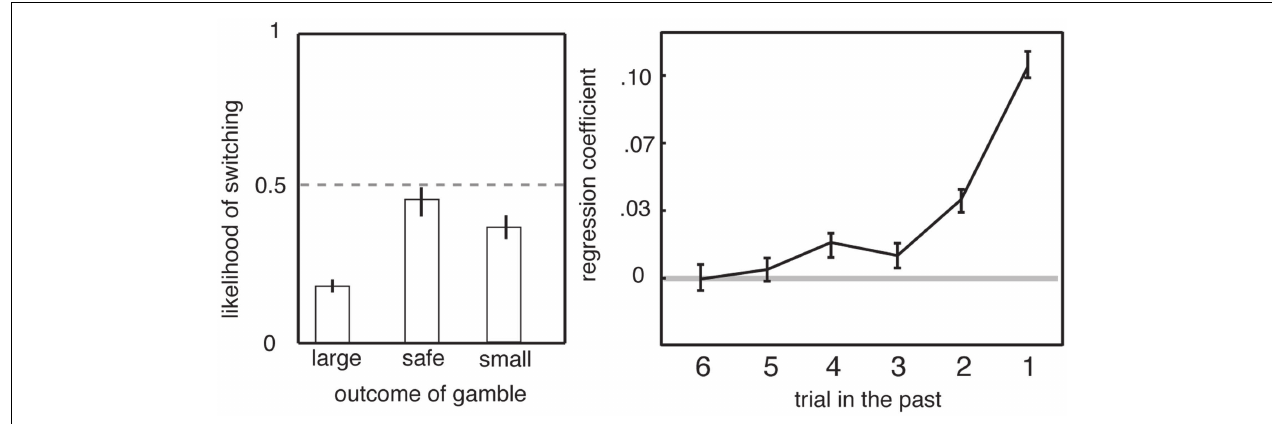
FIGURE 4 | Preferences in gambling task depend on recent outcomes. Left: likelihood of switching from risky to safe strategy depends on outcome of previous trial. Right: preference depends on the outcomes of the five most recent gambles. Adapted from (Hayden et al.,